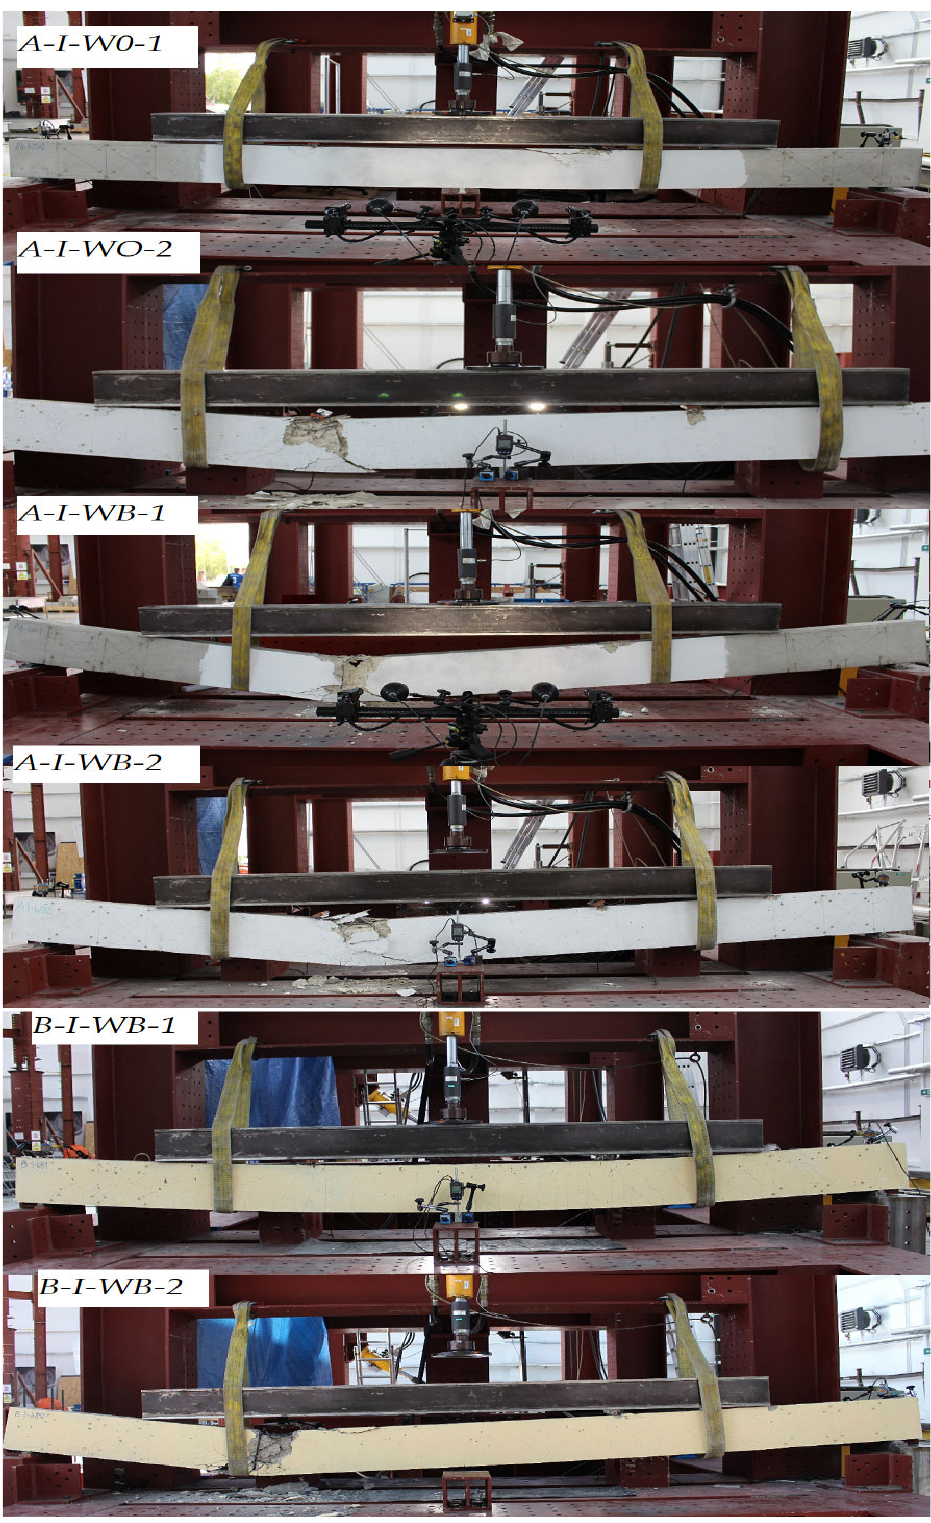
Figure 3. Failure mode of RC and BFRC RC beams.